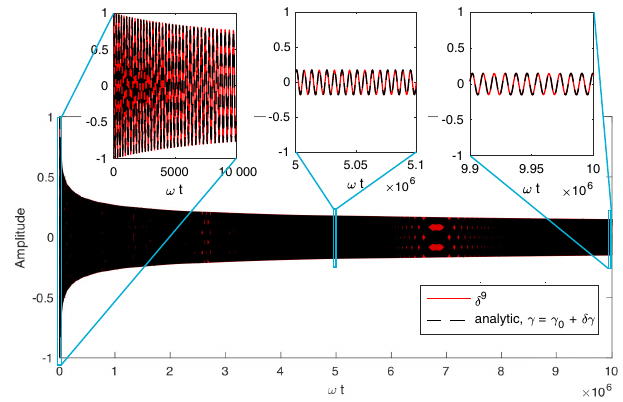
FIG. 10. Demonstration of method accuracy; Betatron oscil- lations for particle linearly accelerated with design energy γ ¼ 1000 to 2 × 10 6 over a total time of ω t ¼ 10 7 , where the betatron ffiffiffi γ p , with a deviation from the design energy of frequency is ω = δγ ¼ 20 , i.e., corresponding to an initial relative energy spread δγ = γ ¼ 2% . The main panel shows the (unresolvable) oscillations for a WKB solution compared with the nonlinear matrix solution including terms up to m ¼ 9 over the full range. The inset panels show expanded regions at the beginning, middle and